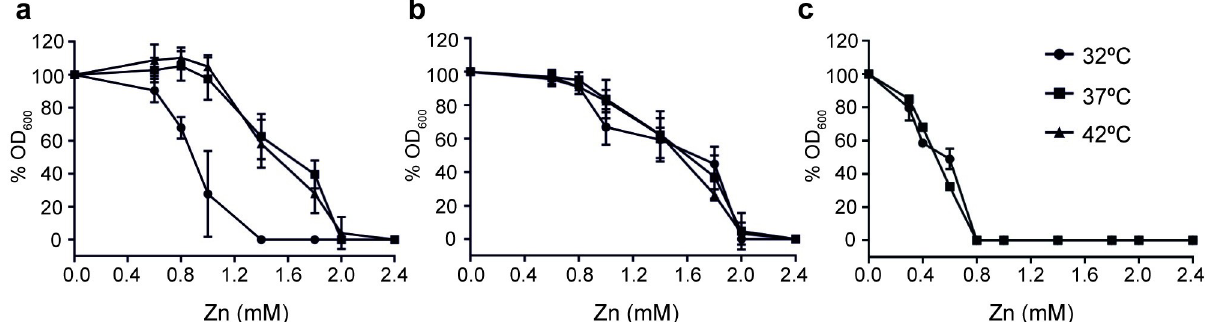
Fig 5. The SL czcD influences C . jejuni temperature dependent Zn(II) sensitivity. Following eight hours of growth in MEM- α containing varying Zn (II) concentrations and at three incubation temperatures, OD 600 values of C . jejuni NCTC 11168 (a), a derivative lacking SL czcD (b) and the czcD - mutant strain (c) were measured. All readings were normalised to the OD 600 value obtained from media lacking Zn(II) and expressed as a percentage. Each data point is the average of three biological replicates each performed in technical triplicate with error bars indicating the standard error of the biological